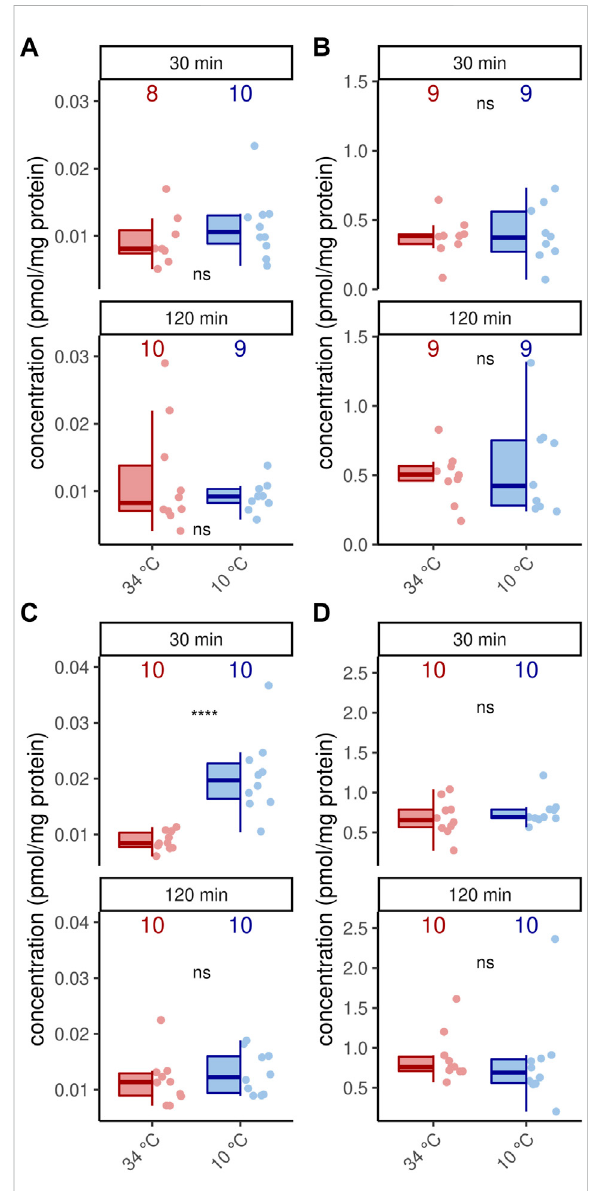
FIGURE 4 Octopamine concentration are stable under cold stress conditions. Only fl ight muscles after 30 min cold stress show increased octopamine concentrations ( p = 0.00008, U = 8, z = − 3.96, r = − 0.89, Mann-Whitney U test). The remaining analysis reveal no differences in the fl ight muscles (A,C) nor the MMTG (B,D) in 1 week old workerbees (A – B) or forager bees (C – D) . ns = p ≥ 0.05, Mann-Whitney U test. For each group/data- set median ± IQR (left part) and individual data points (right part) are